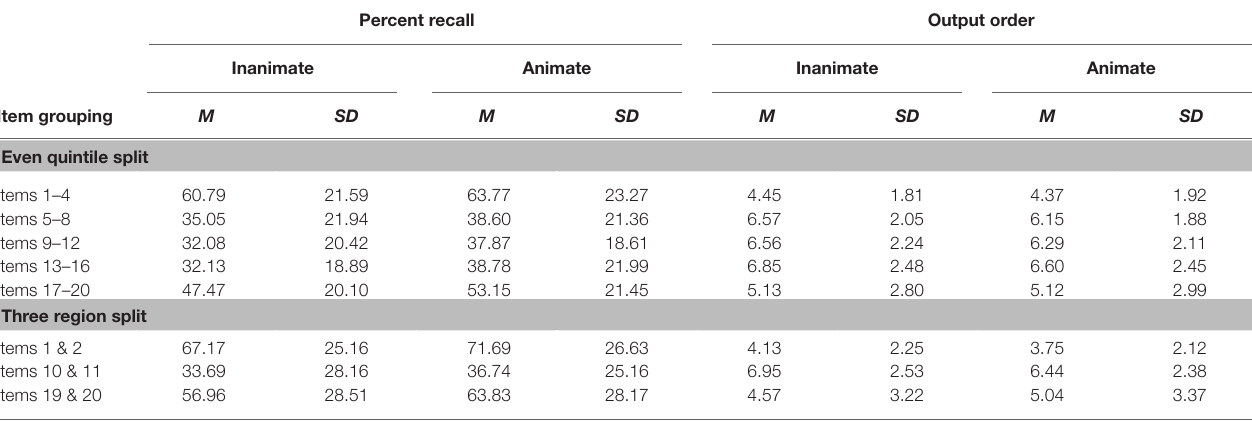
TABLE 2 | Percent recall and output order by animacy and item grouping. Percent recall Output order Animate